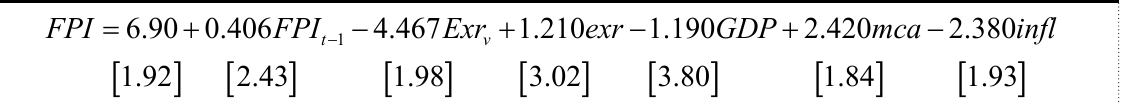
Table A4. VAR estimates